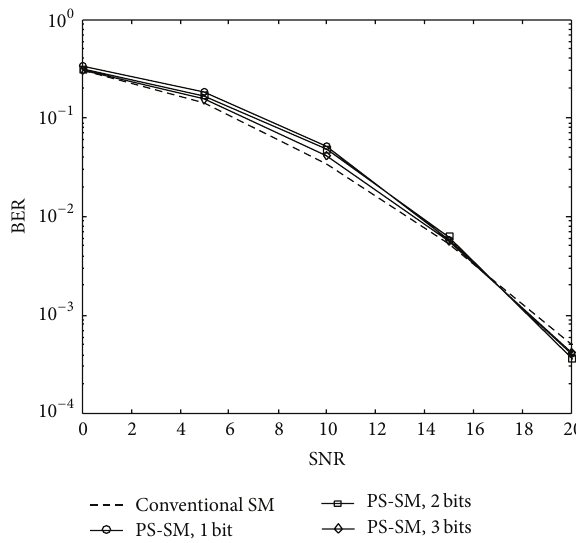
Figure 5: Performance of PS-SM with minimum transmit